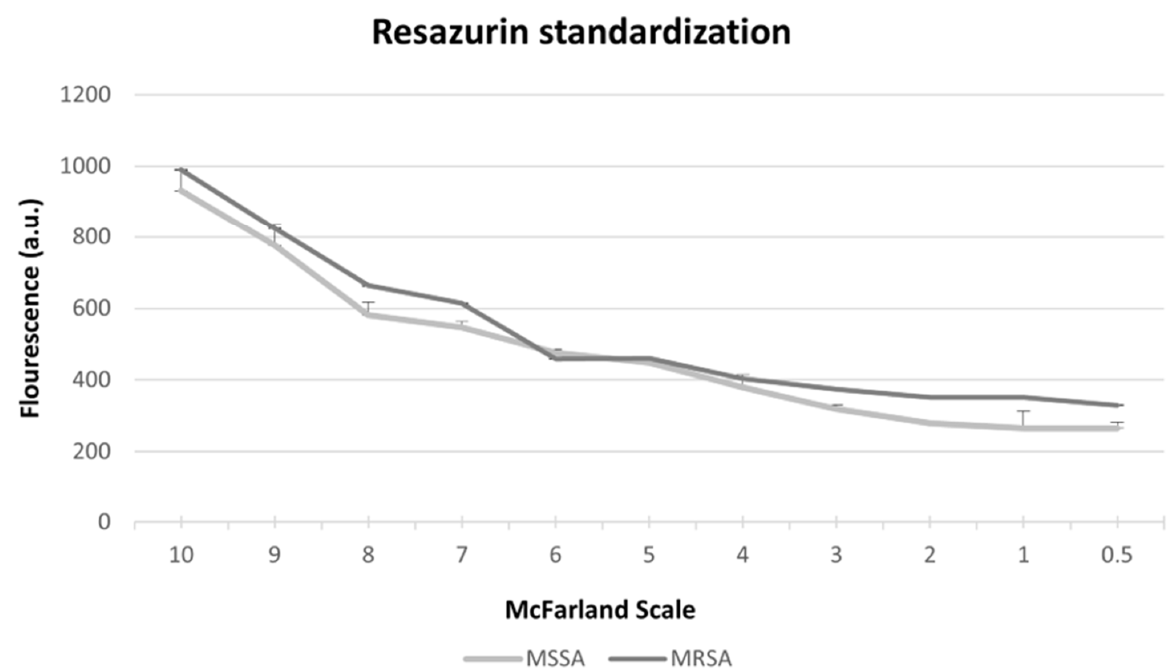
Figure 5. Absorbance of Resazurin on the McFarland scale (0.5 to 10) in the MSSA and MRSA strains.